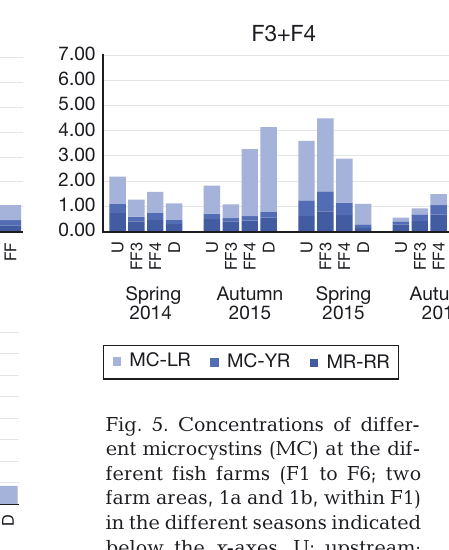
Fig. 4. Organism numbers (org. ml −1 ) counted by micro- scope at the different fish farms (F1 to F6; two farm ar- eas, 1a and 1b, within F1) in the different seasons indi- cated be low the x -axes. U: upstream; FF: fish farm;